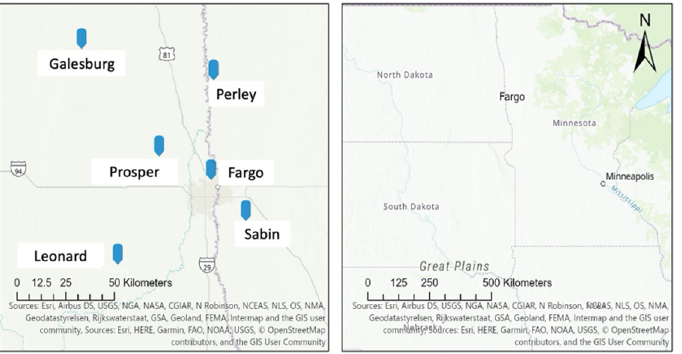
Figure 1. Location of weather stations used for the current study.